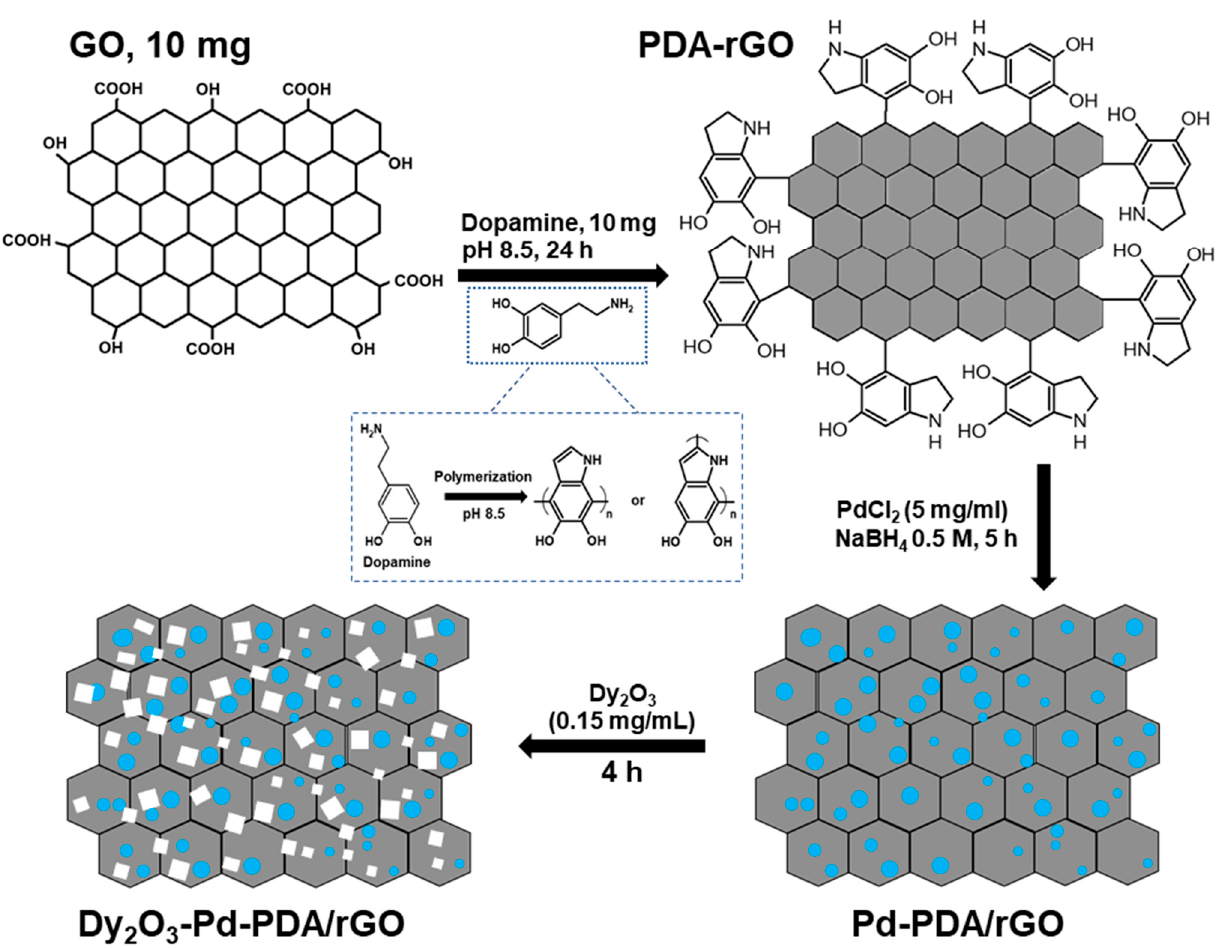
Figure 1. Schematic diagram of the synthesis process of the Dy 2 O 3 -Pd-PDA/rGO nanocomposite.